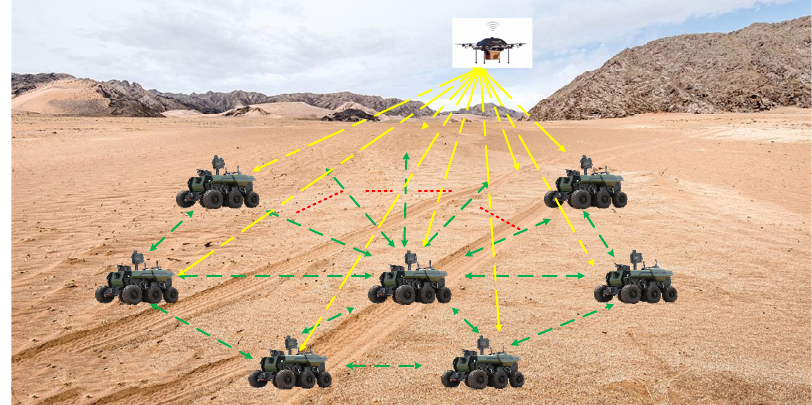
Figure 1. Schematic diagram of large-scale unmanned vehicle networking.